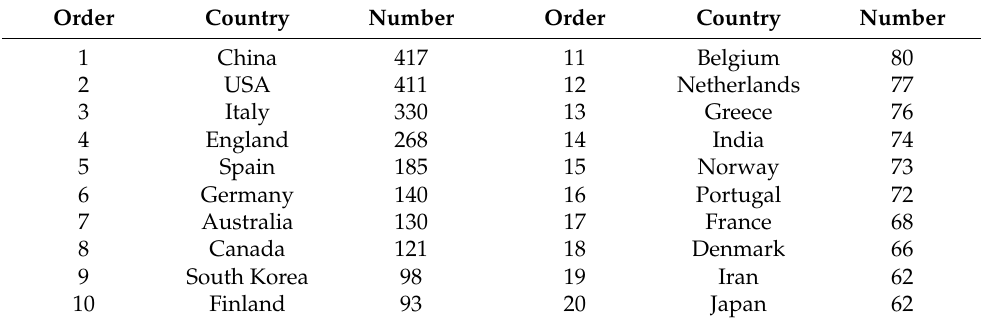
Table 1. Top 20 countries with zero-energy building studies, 2000–2021.